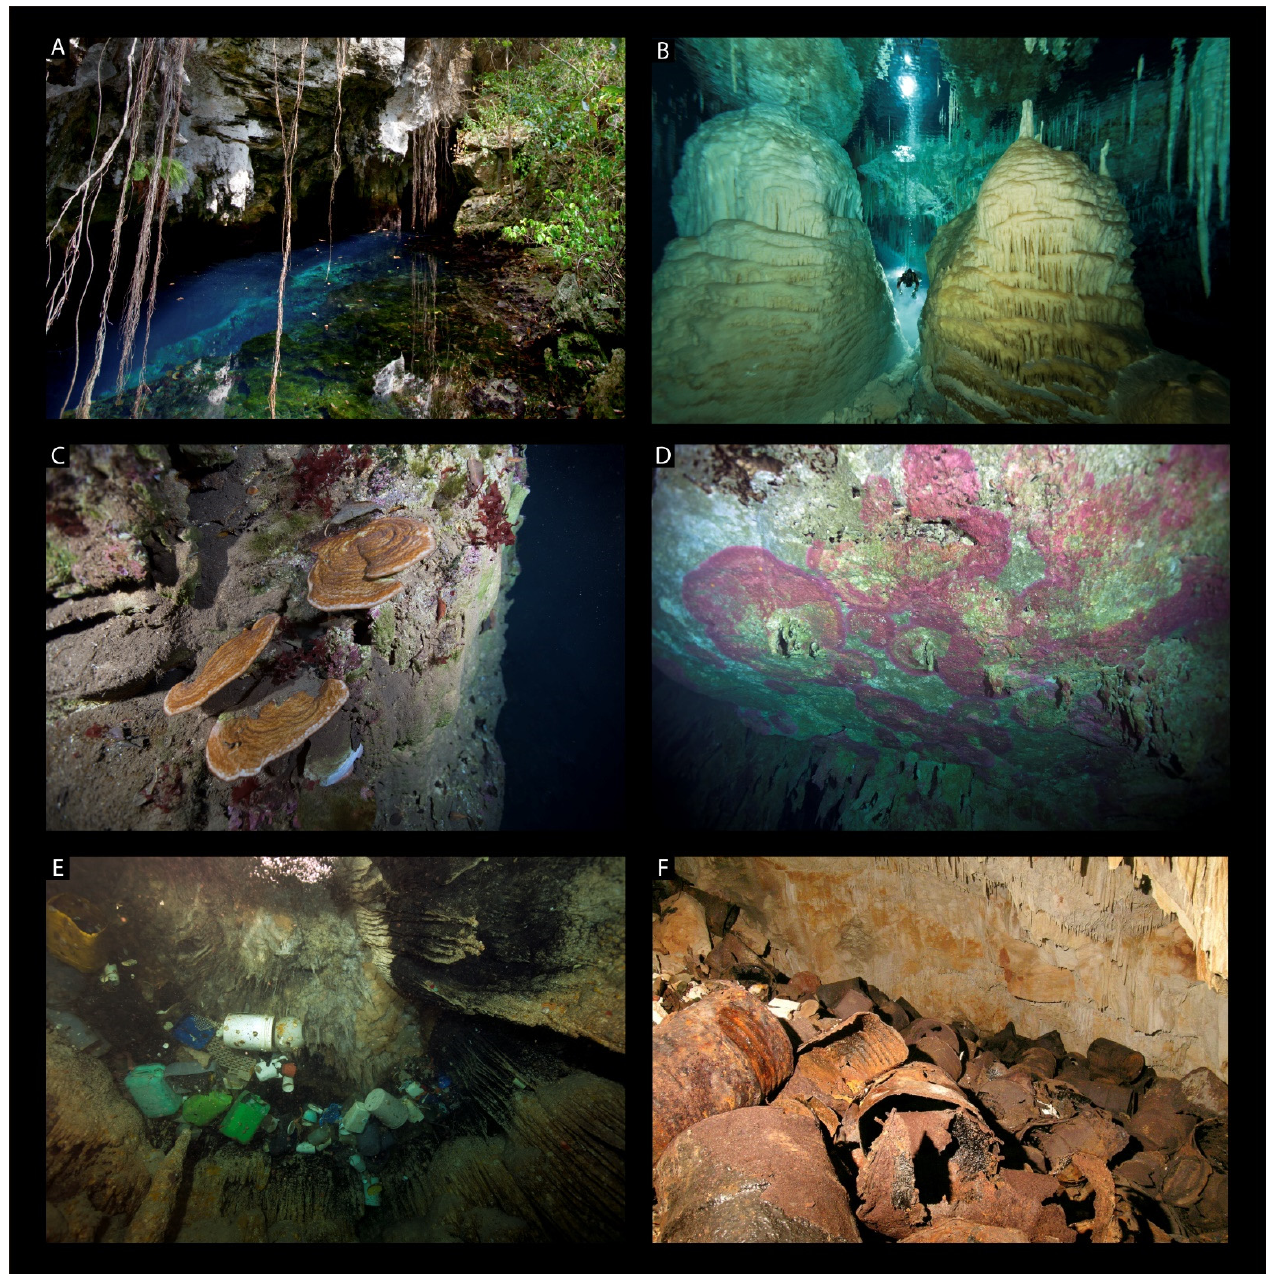
Figure 2. Caves of the Walsingham Tract. ( A ) Deep Blue Cave entrance pool, ( B ) Cave diver between underwater stalagmites near the Crystal Cave, ( C ) Fragile saucer coral ( Agarcia fragilis Dana, 1848) in the cavern pool of Deep Blue, ( D ) Coraline algae in the cavern ceiling of Deep Blue, ( E ) Submerged plastic garbage floating on the ceiling in the Palm Cave System, and ( F ) Rusting and disintegrating bitumen barrels in Bitumen Cave (in the Walsingham Tract). Photo credits: Tamara Thomsen ( A ); Jill Heinerth ( B , E ).